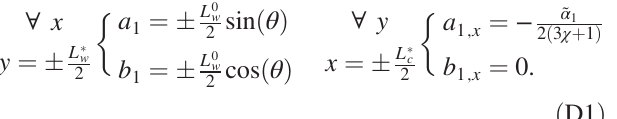
Fig. 10 for the amplitude of this vector field over the fabric.